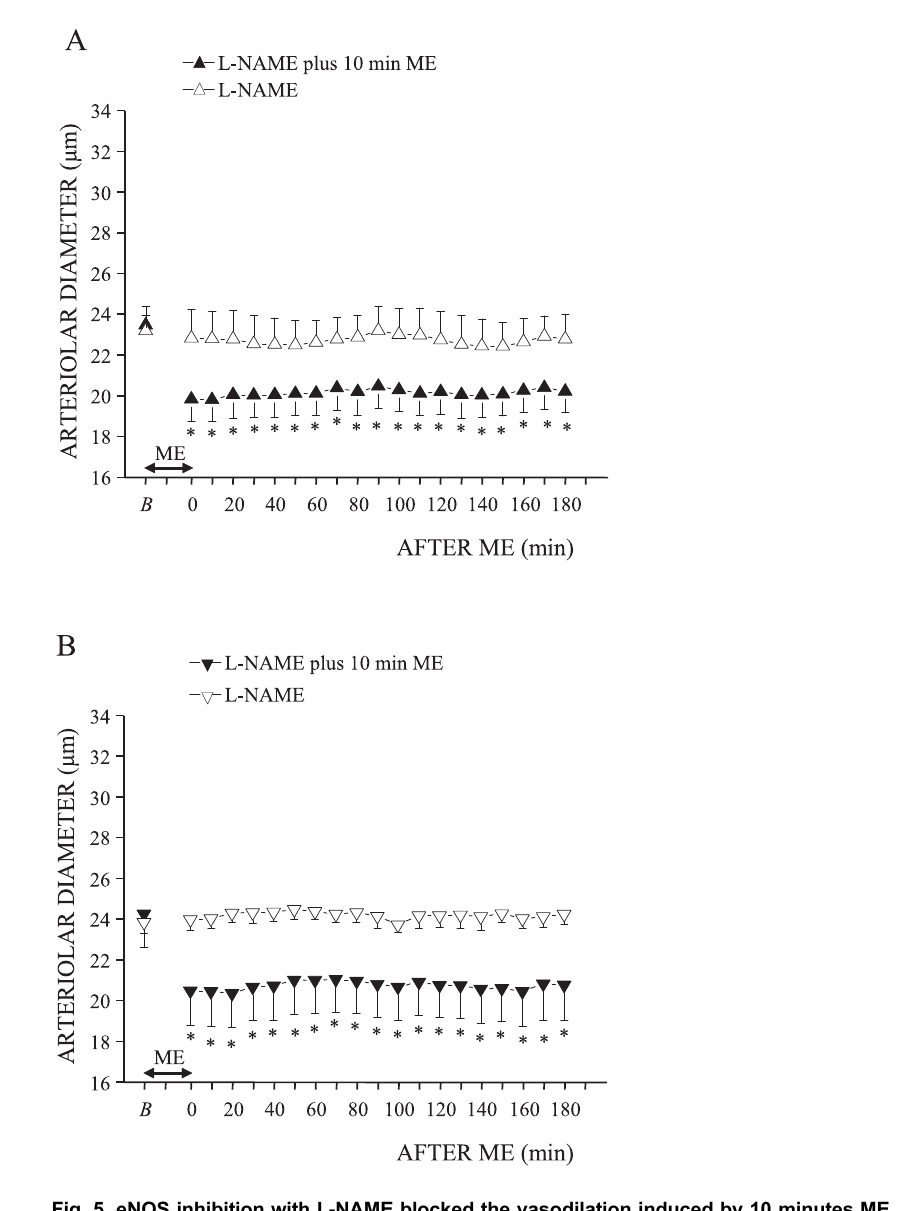
Fig. 5. eNOS inhibition with L-NAME blocked the vasodilation induced by 10 minutes ME. Both i.v. infusion of L-NAME (n 5 4 rats, see Fig. 1B) (A) and topical application of L-NAME (n 5 4 rats, see Fig. 1C) (B) abolished the increase of the pial order 2 arterioles diameter (filled triangle) due to ME without affecting the constriction observed during ME. L-NAME alone (n 5 4 rats, open triangle) did not induce any changes in the pial order 2 arterioles diameter. * Significantly different from the baseline